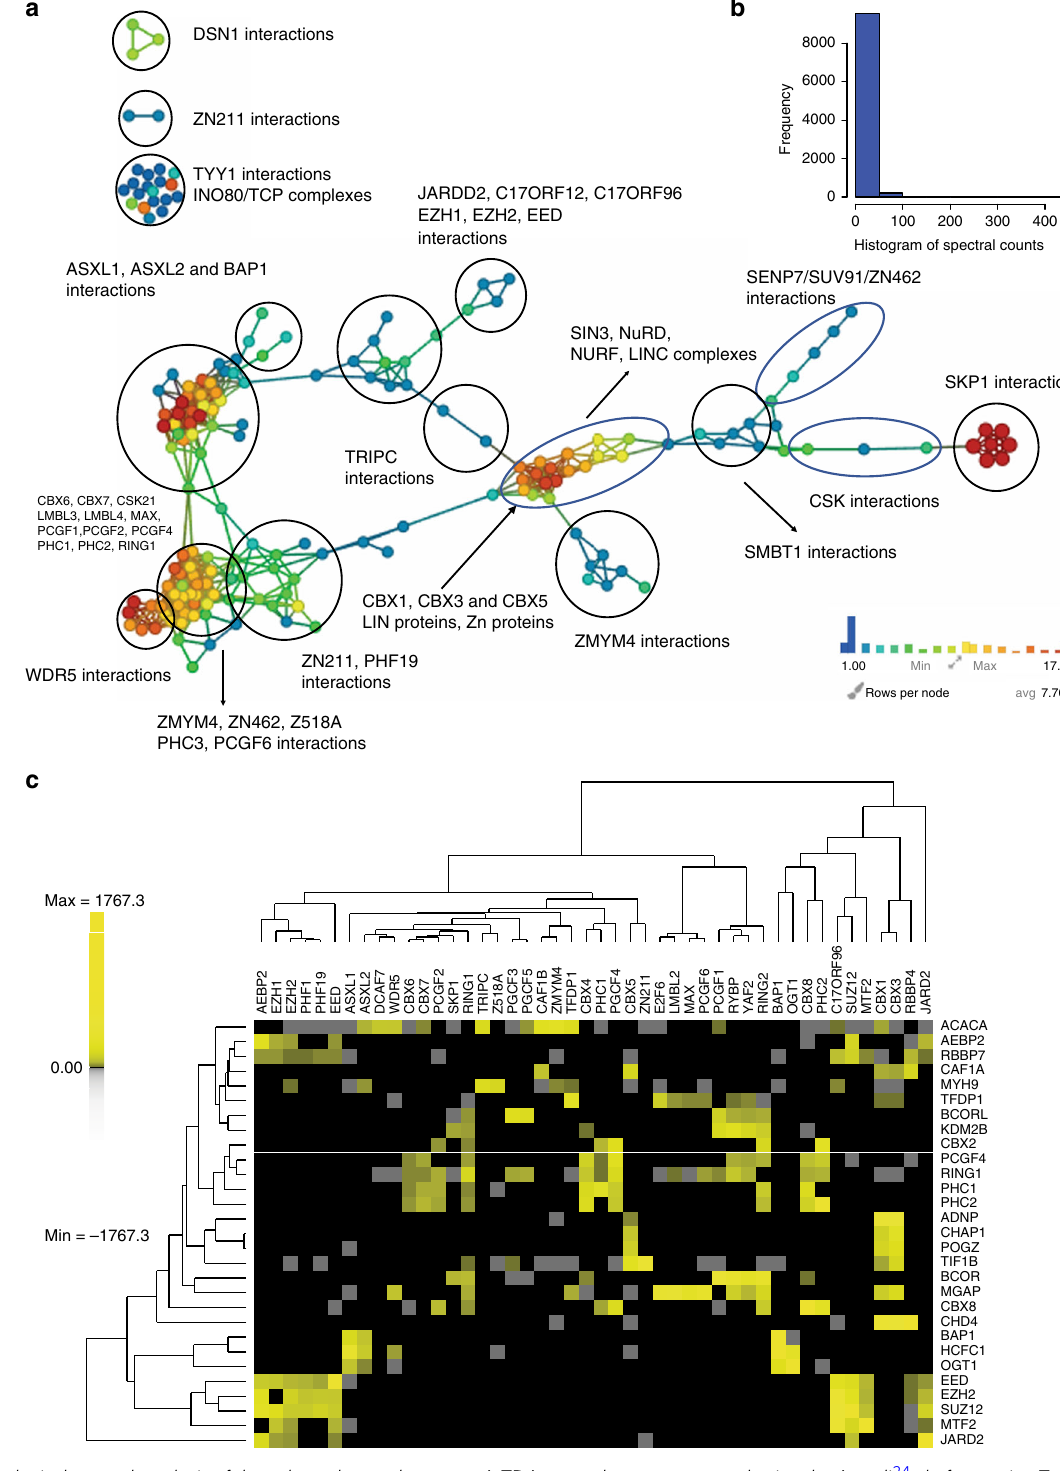
Fig. 7 Topological network analysis of the polycomb complexome. a A TDA network was constructed using the Ayasdi 24 platform using TopS values as the input. Within the Ayasdi platform 24 Norm correlation was used for metric with two fi lter functions of Neighborhood lens 1 and Neighborhood lens 2, the resolution was set to 30 and a gain 4x eq. was used. Proteins are colored based on the rows per node. Color bar: red: high values, blue: low values. All proteins (408) that have a TopS value of 20 in at least one bait were included in here. b A histogram of the spectral counts for 9,853 candidate interactions was plotted. ( c ) Hierarchical biclustering on a subset of baits and preys within the dataset. Brie fl y, preys were included if they had a score of more than 100 in more than one bait and baits were excluded if none of the 32 proteins that passed this criteria had a score of 50 of higher in the bait. Also, RBBP4, RBBP7, CSK21, and CSK22 were removed since proteins passing the criteria above were only in RBBP4 and RBBP7 or CSK21 and CSK22. Rows and columns were clustered using Euclidean distance and Ward linkage as the method. Yellow corresponds to high TopS values and gray indicates negative scores. TDA topological data analysis, TopS topological